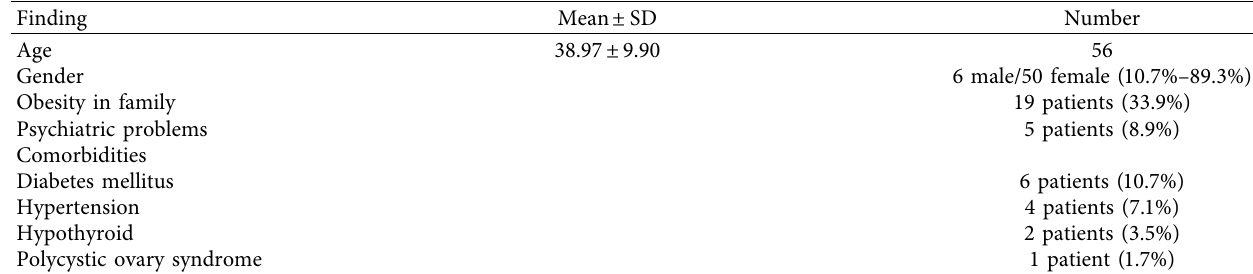
Table 1: Demographic findings of patients.